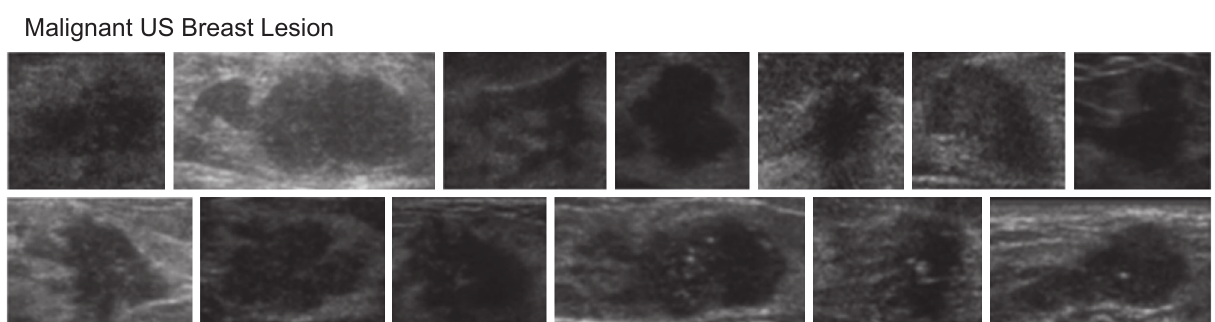
Malignant US Breast